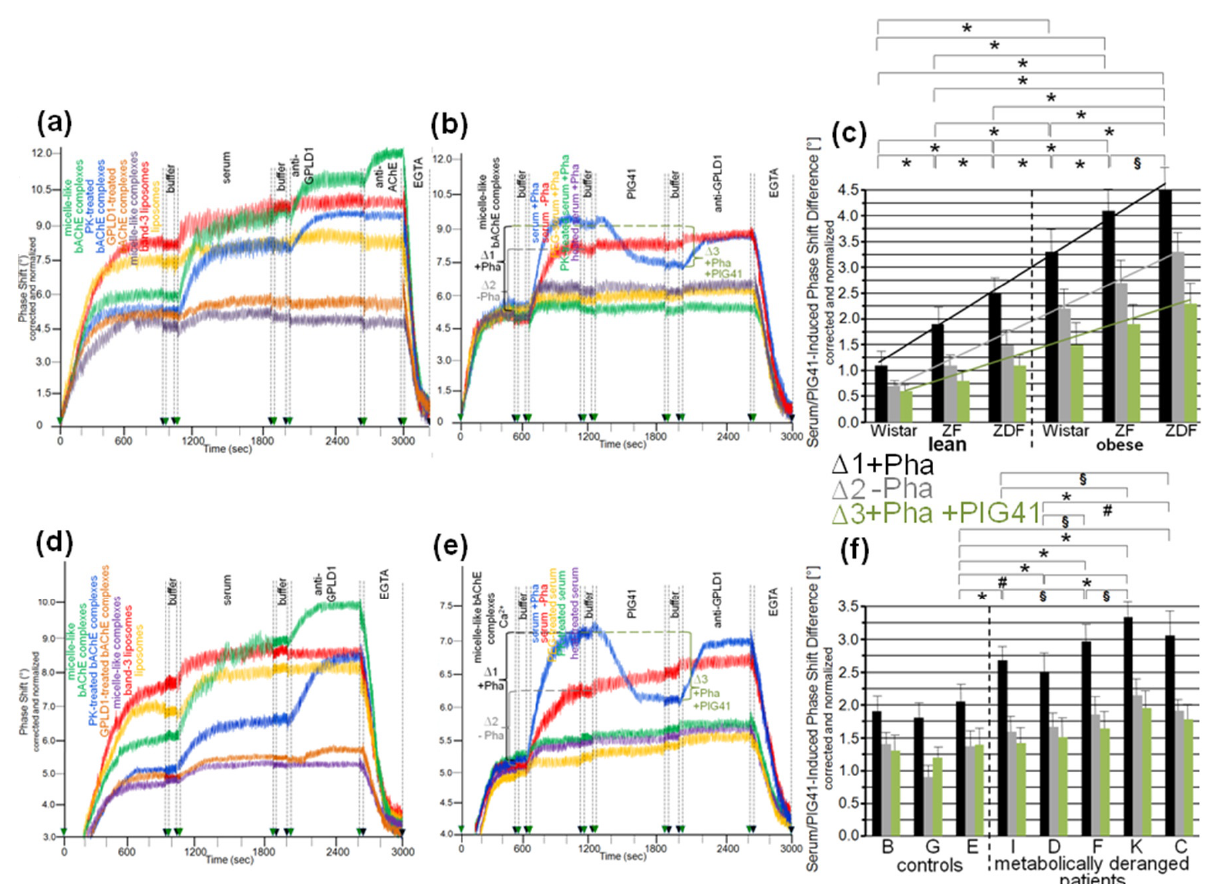
Figure 6. Structural requirements for the interaction of rat and human serum components with micelle-like bAChE complexes. Micelle-like complexes reconstituted in the absence ( a , d , purple curves) or presence of bAChE at the “optimized” constituent ratio and then left untreated ( a , d , green curves; b , e ) or treated with proteinase K (PK; a , d , blue curves) or GPLD1 ( a , d , brown curves) and liposomes reconstituted in the absence ( a , d , orange curves) or presence of band-3 protein ( a , d , red curves) were injected into uncoated chips in the presence of Ca 2+ (5 mM). Following washing of the chips with buffer, serum from obese ZDF rats ( a,b ) or pooled serum from metabolically deranged patients ( d , e ) that had been left untreated ( a , d ; b , e , blue and red curves) or treated with proteinase K (PK; b , e , green curves) or heat (60 °C, 15 min; b , e , purple curves) or precipitated with PEG6000 (use of supernatant; b , e , orange curves) was injected in the presence of Pha (0.5 mM; a , d ; b , e , blue, orange, green, purple curves) or its absence ( b , e , red curves). After washing with buffer, PIG41 (30 μ M) ( b , e only), anti-GPLD1 antibody in the absence or presence of Pha in correspondence to serum injection, then anti-AChE antibody ( a only) and finally EGTA were injected. Correction and normalization of the phase shift were performed as described for Figure 1. ( b , e ) The serum- and PIG41-induced phase shift difference in the presence ( ∆ 1, black lines and brackets) or absence of Pha ( ∆ 2, grey lines and brackets) or in the presence of Pha and then PIG41 ( ∆ 3, green lines and brackets) is indicated. ( c , f ) The experiment was performed with sera from the six rat groups ( n = 8) and the individual human probands coinjected with Pha as described above for b , e (blue curves) and repeated three times (using the same chips and different preparations of micelle-like bAChE complexes) with similar results (16 and 8 regeneration cycles per chip, respectively). The serum- and PIG41-induced phase-shift difference ( ∆ 1, black bars and lines; ∆ 2, grey bars and lines; ∆ 3, green bars and lines) measured in quadruplicate is given as means ± SD. The comparisons between the rat groups ( c ) and human probands ( f ) are shown for the presence of Pha ( ∆ 1, black bars) only (* p ≤ 0.01, # p ≤ 0.02, § p ≤ 0.05). Linear regression analysis is indicated by the lines.